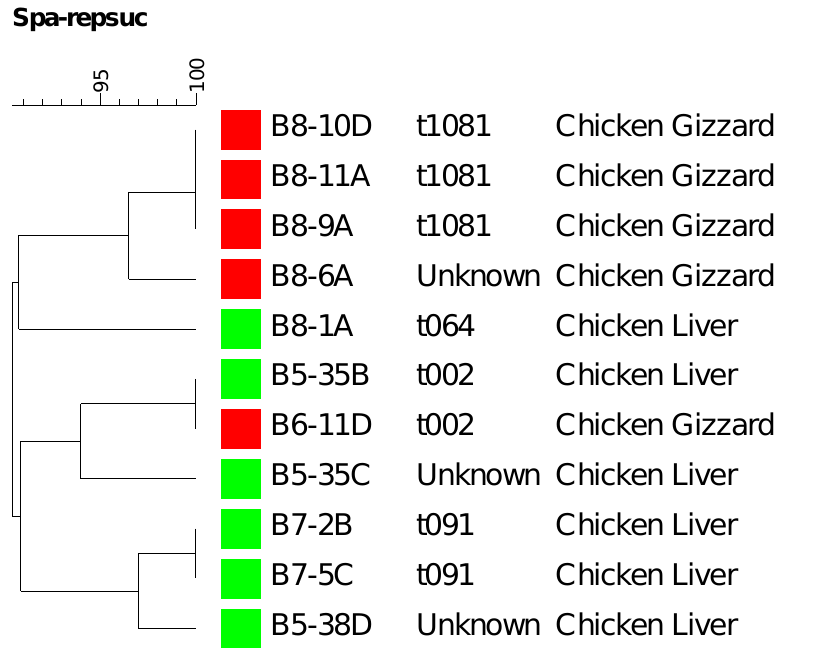
Figure 1. A dendrogram showing spa typing for a subset of the recovered Staphylococcus aureus strains representing chicken livers and chicken gizzards sources. Strains isolated from the same meat source are labeled by the same color